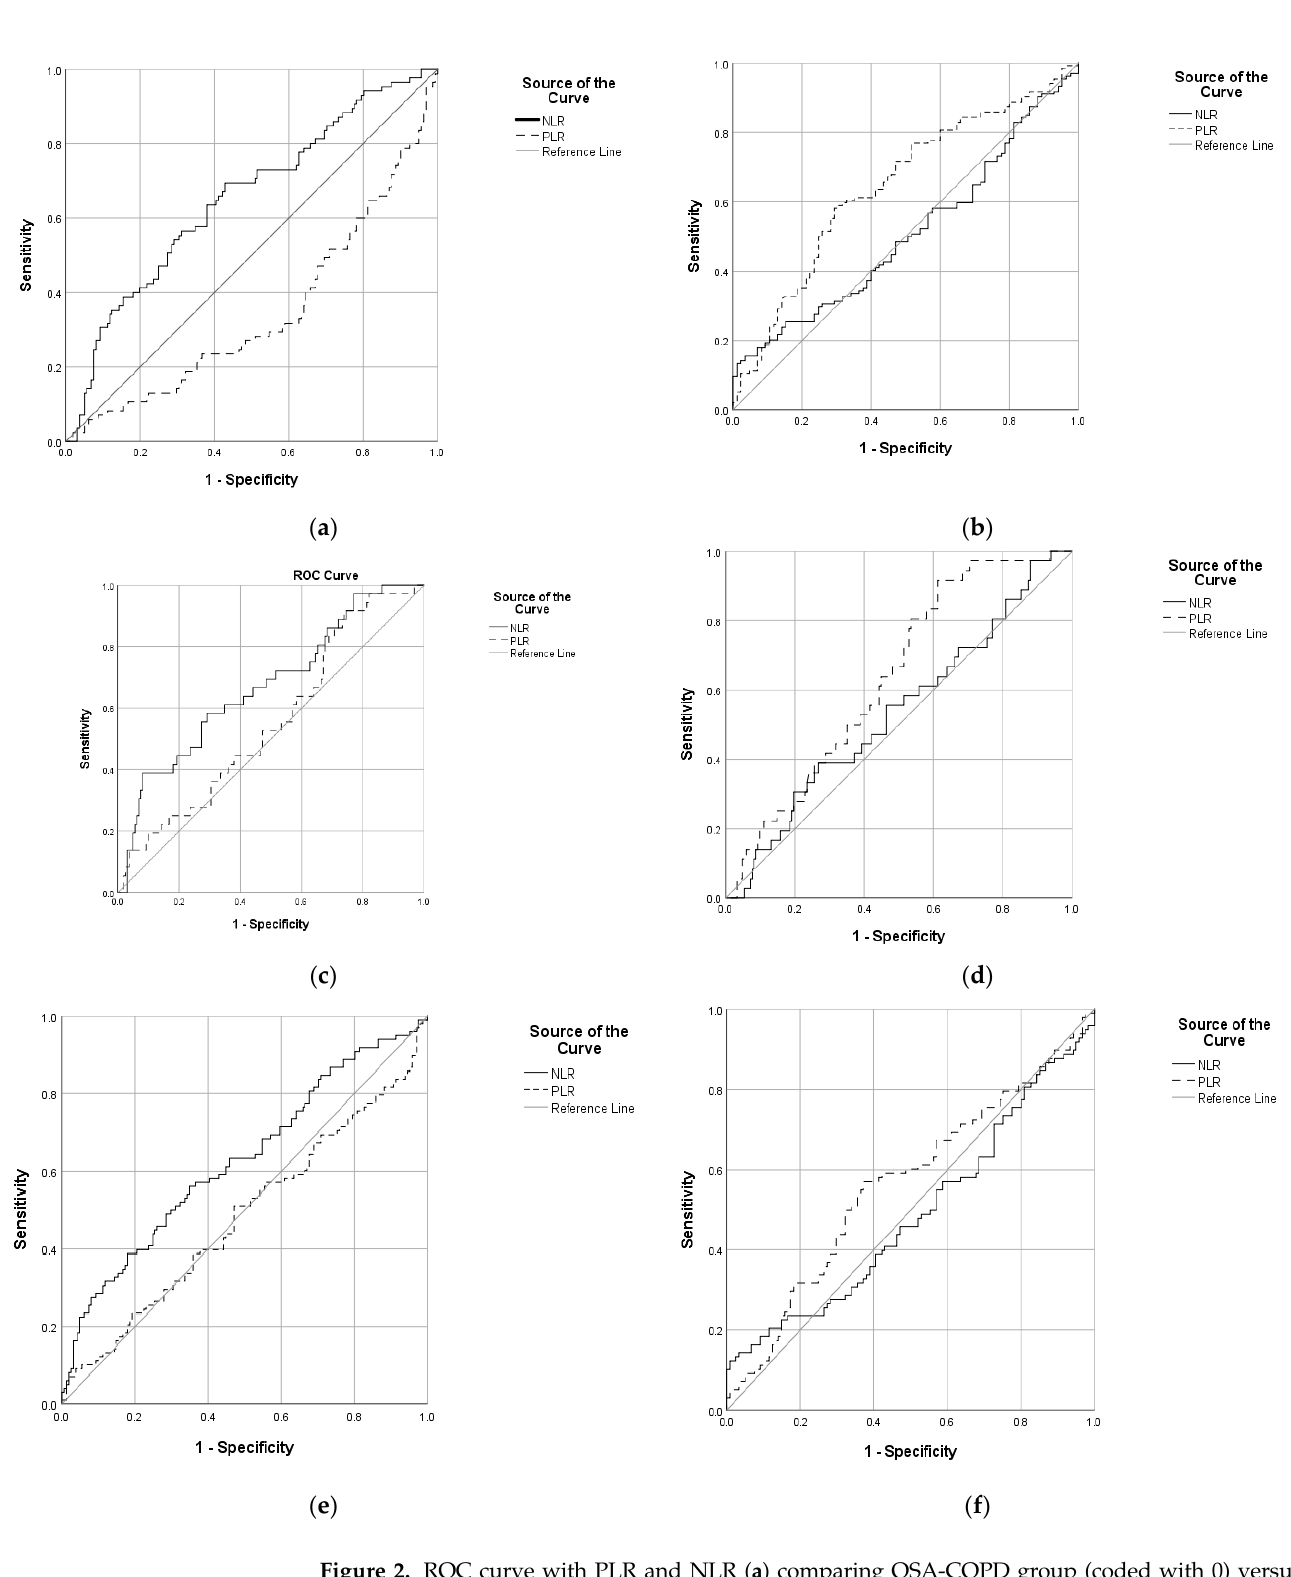
Figure 2. ROC curve with PLR and NLR ( a ) comparing OSA-COPD group (coded with 0) versus control group; ( b ) comparing OSA-COPD group (coded with 0) versus interstitial lung disease and bronchiectasis groups; ( c ) comparing interstitial lung disease group (coded with 1) versus control group; ( d ) comparing interstitial lung disease group (coded with 1) versus OSA-COPD and bronchiectasis groups; ( e ) comparing bronchiectasis (coded with 1) group versus control group; ( f ) comparing bronchiectasis (coded with 1) group versus OSA-COPD and interstitial lung disease groups.